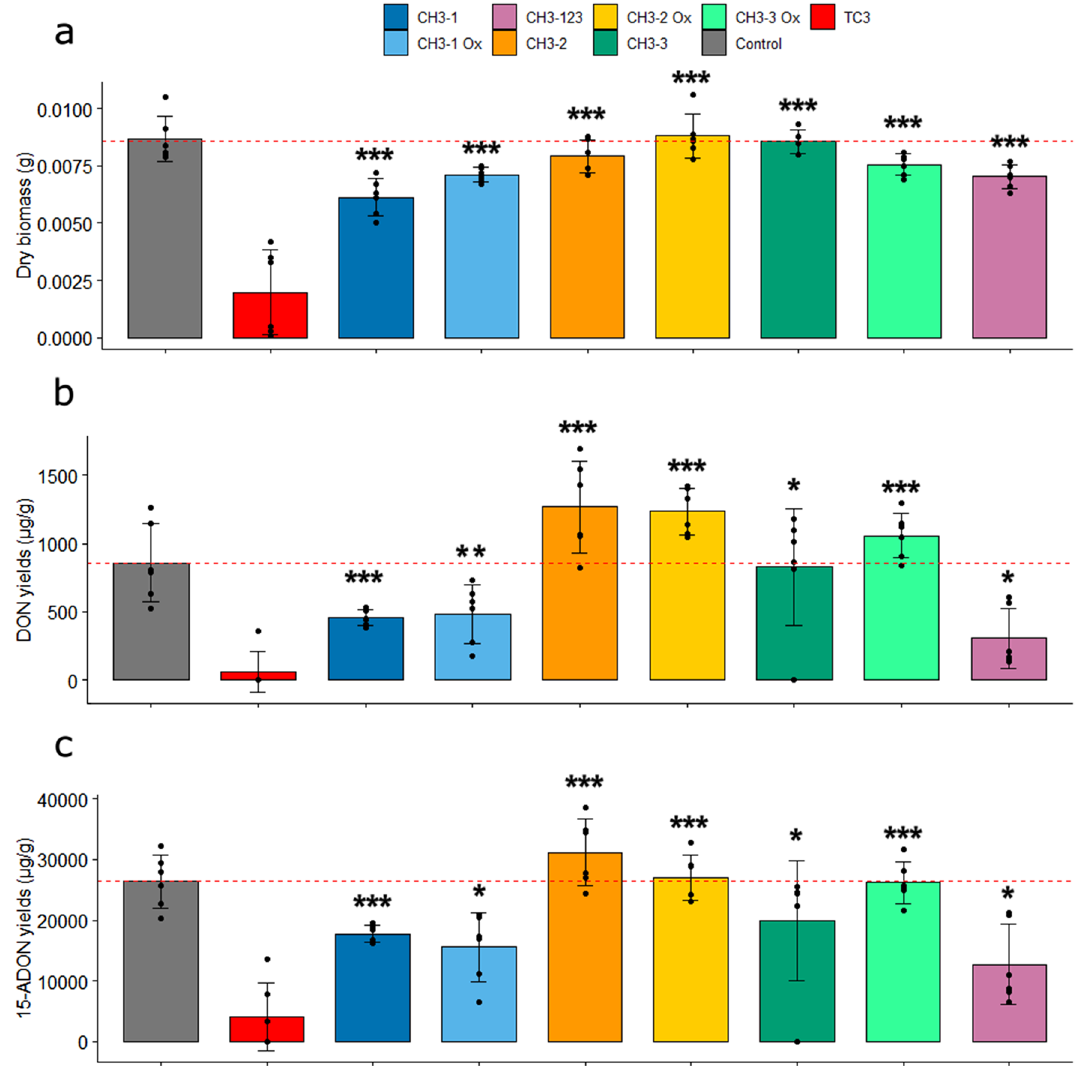
Figure 4. Antifungal and anti-mycotoxin activity of linear, methylated and oxidized TC3. Effect of reduced TC3, TC3-CH3-1, TC3-CH3-2, TC3-CH3-3, TC3-CH3-1 Ox, TC3-CH3-2 Ox, TC3-CH3-3 Ox and TC3-CH3-123 at 50 µM on the fungal biomass weight of F. graminearum ( a ) and on the production of DON ( b ) and 15-ADON ( c ) in 10-day-old broths. Significant differences are labelled (* p < 0.05, ** p < 0.01 and *** p <